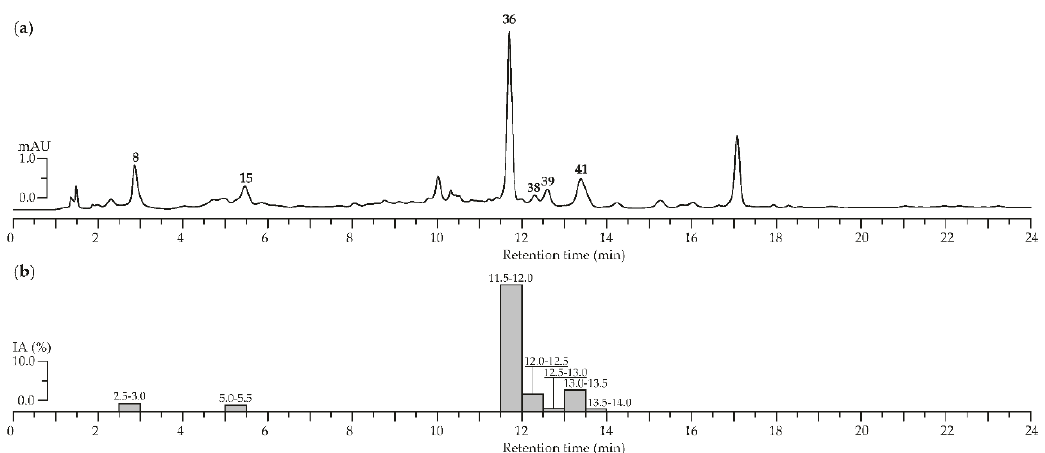
Figure 3. ( a ) High-Performance Liquid Chromatography with Photodiode Array Detection (HPLC-PDA) chromatograms of A. asiatica extract at 270 nm. Compounds numbered as 8 (4- O -caffeoylquinic acid), 15 (epigallocatechin), 36 (agrimoniin), 38 (ellagic acid), 39 (quercetin-3- O -(6”- O -rhamnosyl)-glucoside), and 41 (quercetin-3- O -glucoside). ( b ) α -Glucosidase inhibiting activity (IA, as a percentage) of HPLC fractions of A. asiatica extract after microfractionation technique. Bars are labeled as retention time range (min).